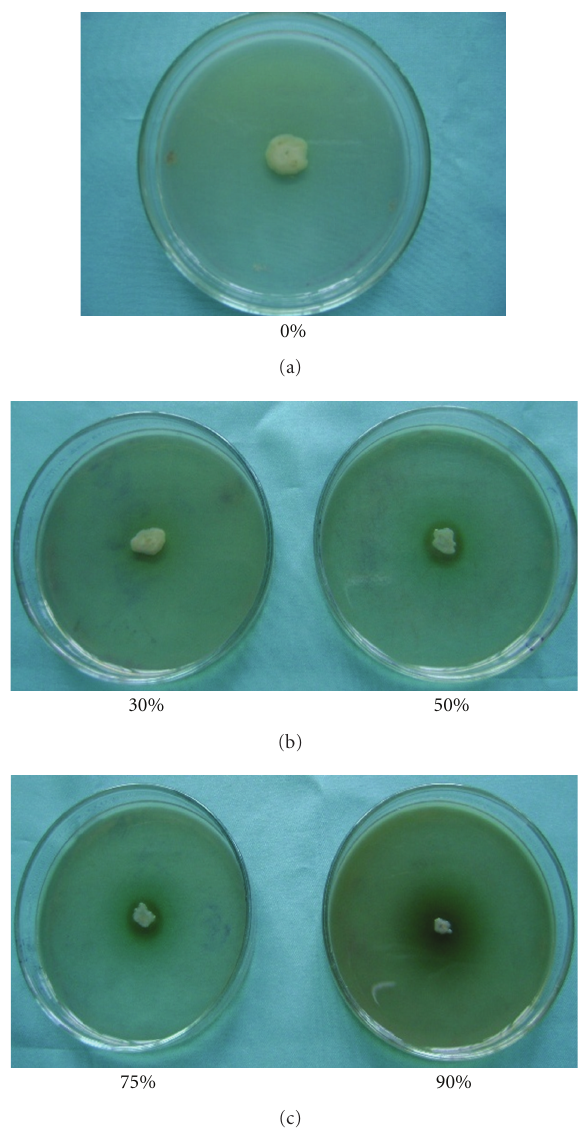
Figure 2: Antibacterial activity of cheerota extract against Ecc P-138 at di ff erent concentrations of extract in YPDA medium.